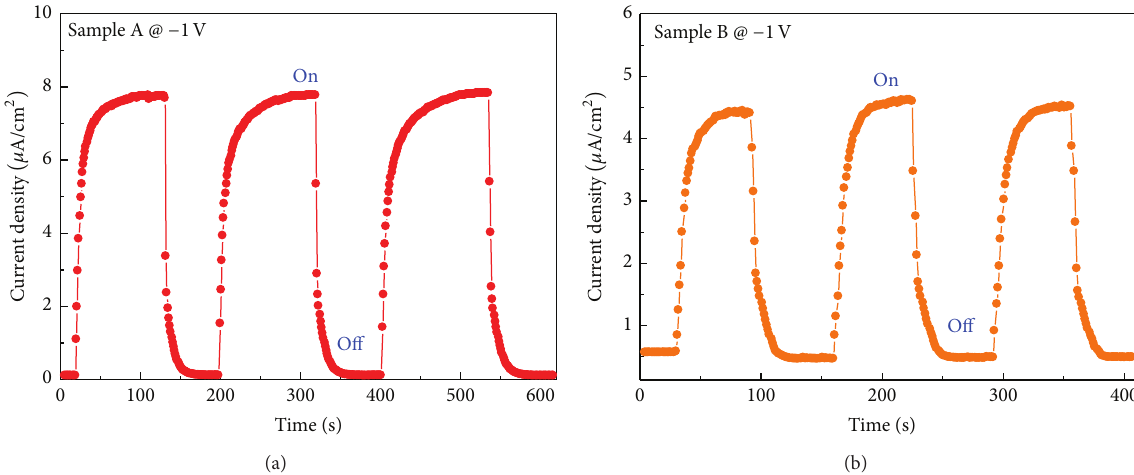
Figure 6: Transient response of photocurrent density of fabricated devices based on ZnO film (HTG) (sample A) and sputter-deposited ZnO film (sample B). Wavelength and intensity of UV light are 365 nm and 3 mW/cm 2 ,